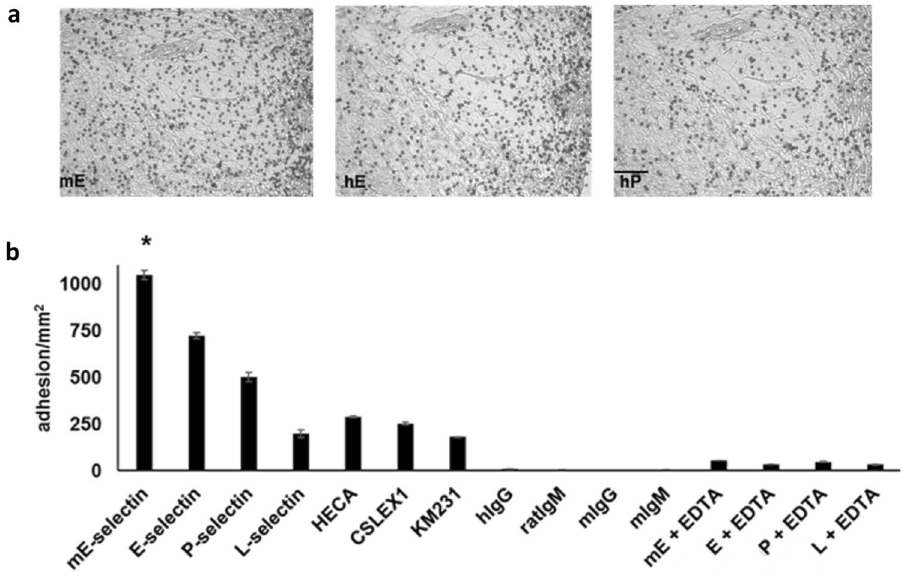
Figure 7. The greatest amount of specific adhesion to SRCC occurs with the mE-selectin DBTA probe. mE-, E-, P-, L-selectin, HECA-452, CLSEX-1, and KM231 DBTA probes adhered to SRCC 22 y/o tissue. (a) Representative images of the adhesion patterns for mE-, E-, and P-selectin are shown. ( b ) The greatest amount of specific DBTA probe adhesion occurred with the mE-selectin probe. Probes were perfused at 250,000 probes/ mL and 0.50 dyne/cm 2 . Specificity of interaction was confirmed using 10 mM EDTA (divalent cation chelator, Ca 2 + is required for selectin/selectin-ligand binding) as well as with hIgG, rat IgM, mouse IgG, and mouse IgM DBTA probes as negative controls. Data shown are mean adhesion ± SD of three technical replicates and are representative of independent experiments conducted on tissue sections from > 3 independent cases colon cancer. Scale bar = 100 µ m. * P < 0.001 compared to all other conditions. See Supplementary Fig. S2 for validation of DBTA probe conjugation. Scale bar = 100 µ